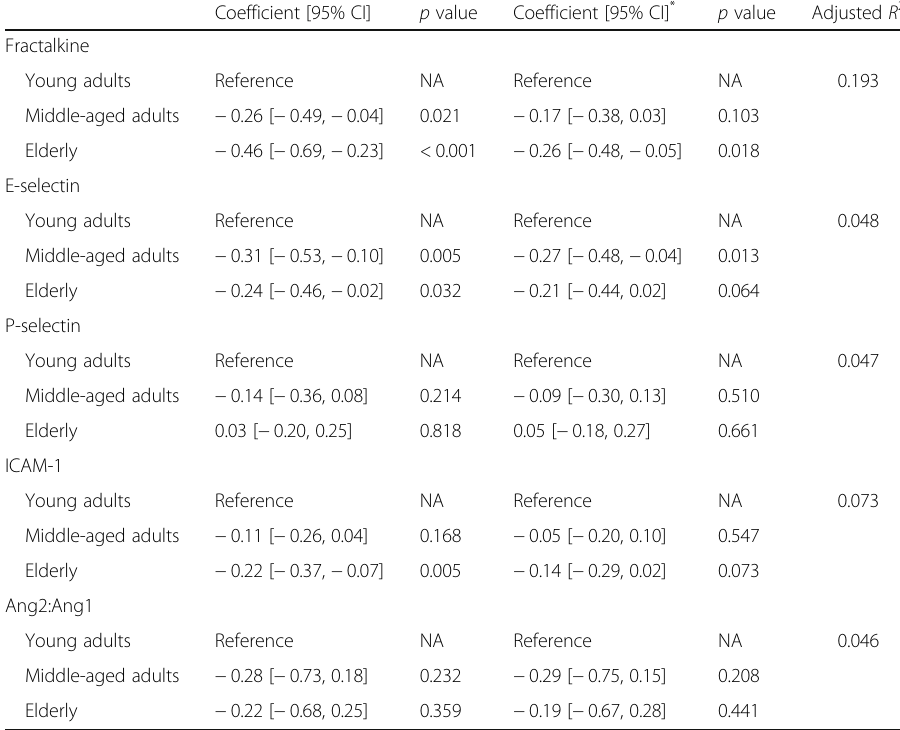
Data is presented as beta-coefficient ( β ) with a 95% confidence interval [CI]. All biomarkers are log-transformed. * Adjusted for ethnic background, gender, admission type, readmission, direct hit for ARDS, Charlson Comorbidity Index, APACHE-IV score adjusted for age, immunodeficiency, tidal volume per predicted body weight, and positive end- expiratory pressure. A p value <0.05 was considered as statistically significant. ICAM-1 intracellular adhesion molecule-1, ANG-2:ANG1 angiopoetin-2:angiopoetin-1. Goodness of fit, adjusted R 2 . NA not